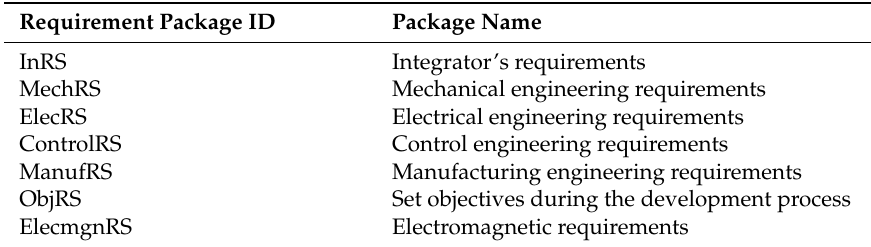
Table 2. Requirement Package IDs.